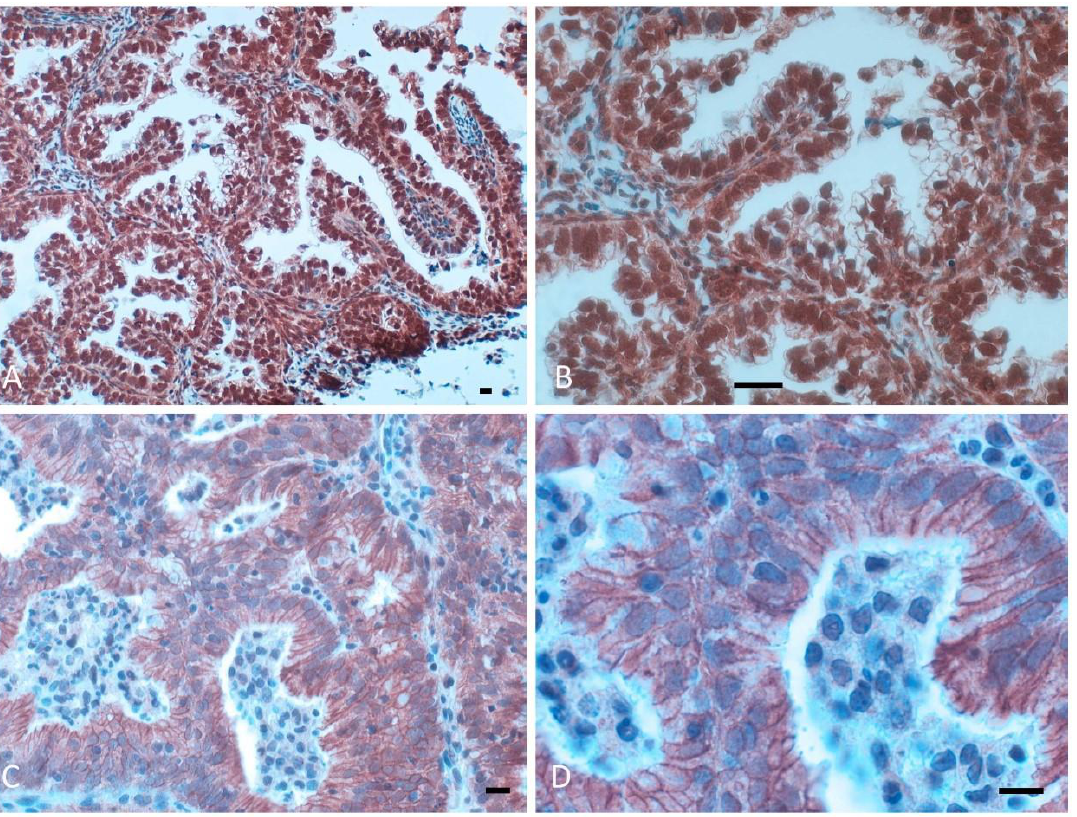
Figure 1. Different patterns of β -catenin expression in endometrial cancer: strong nuclear expression in ( A ) ( × 200) and ( B ) ( × 400); membranous expression absent in ( C ) ( × 400) or weak in ( D ) ( × 600) nuclear expression of β -catenin. Scale bar = 50 μm.